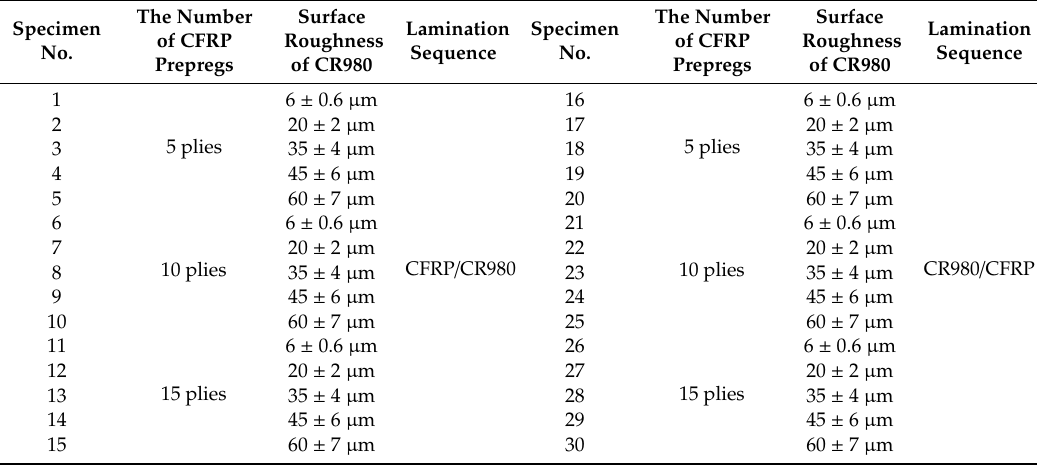
Table 2. Kinds of hybrid composites.